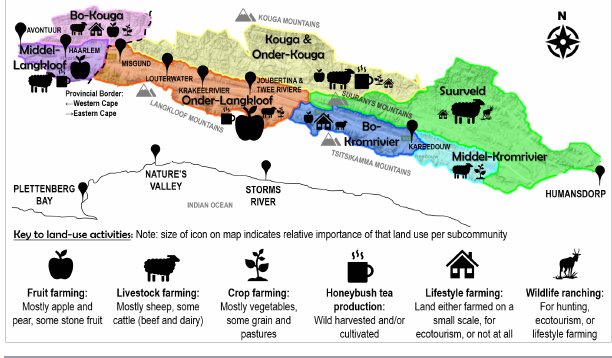
Fig. 1 . Map of the Langkloof region indicating different agricultural subcommunities, primary land-use activities, and towns or villages. Each colored patch on the map indicates a different subcommunity. Note: information generated from interviews.